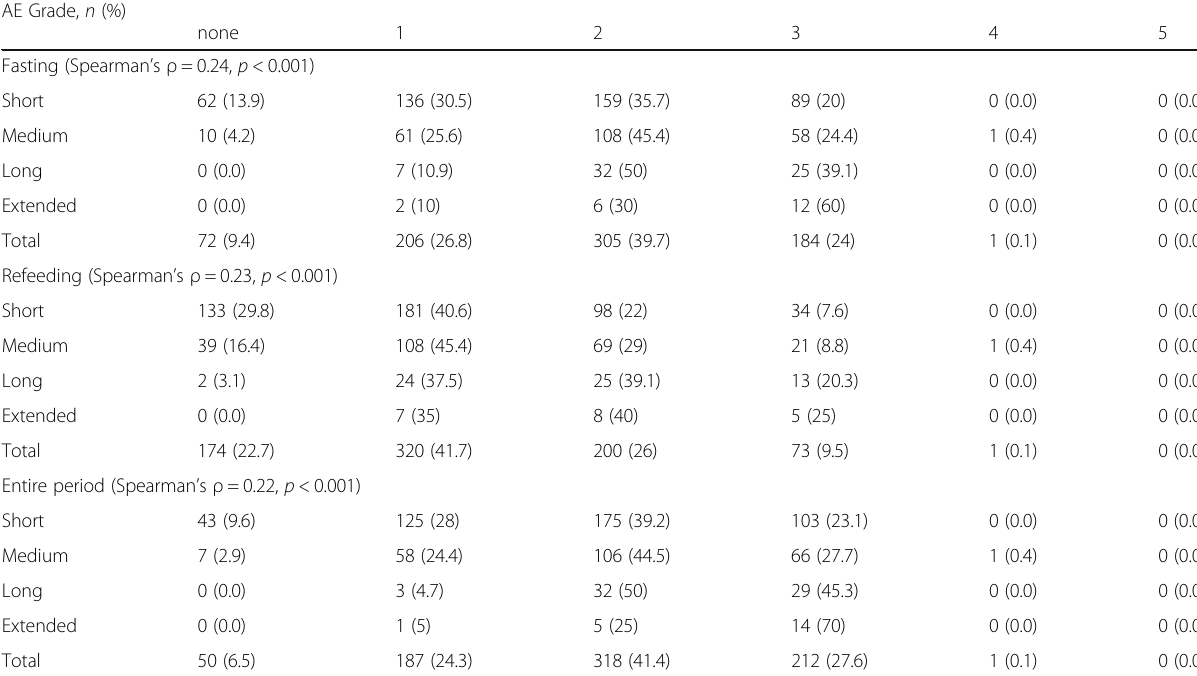
Table 2 Highest Grade AE experienced by duration of